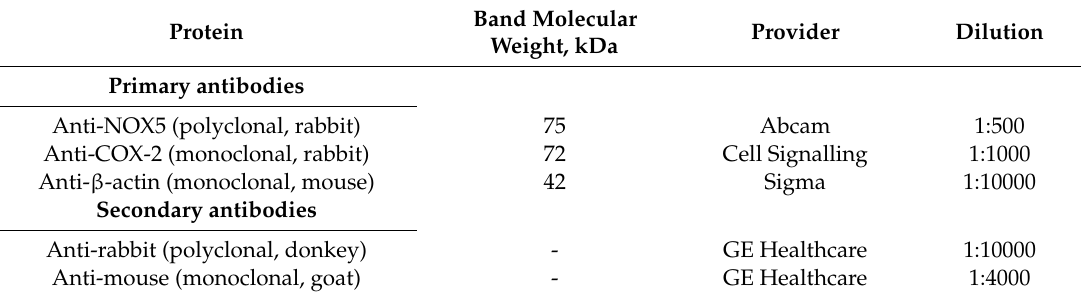
Table 2. Primary and secondary